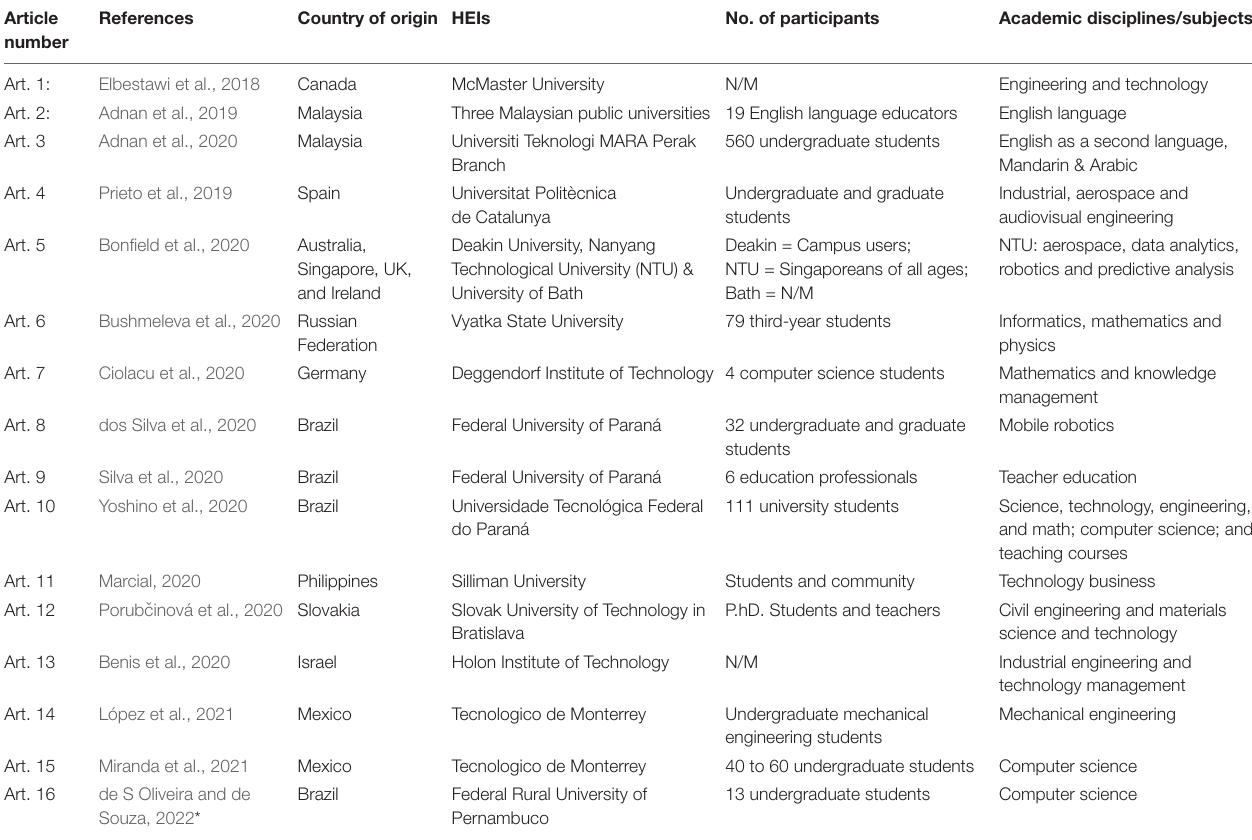
TABLE 1 | Authors’ countries of origin, years of publication, HEIs, participants, and academic